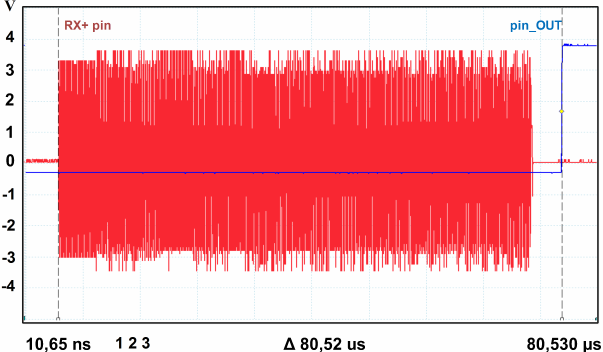
Figure 9. Writing frame capture at 10 Mbps. Frame reception to cryptographic processing end can be seen. Total time from beginning of frame to output is 80.520 µs.